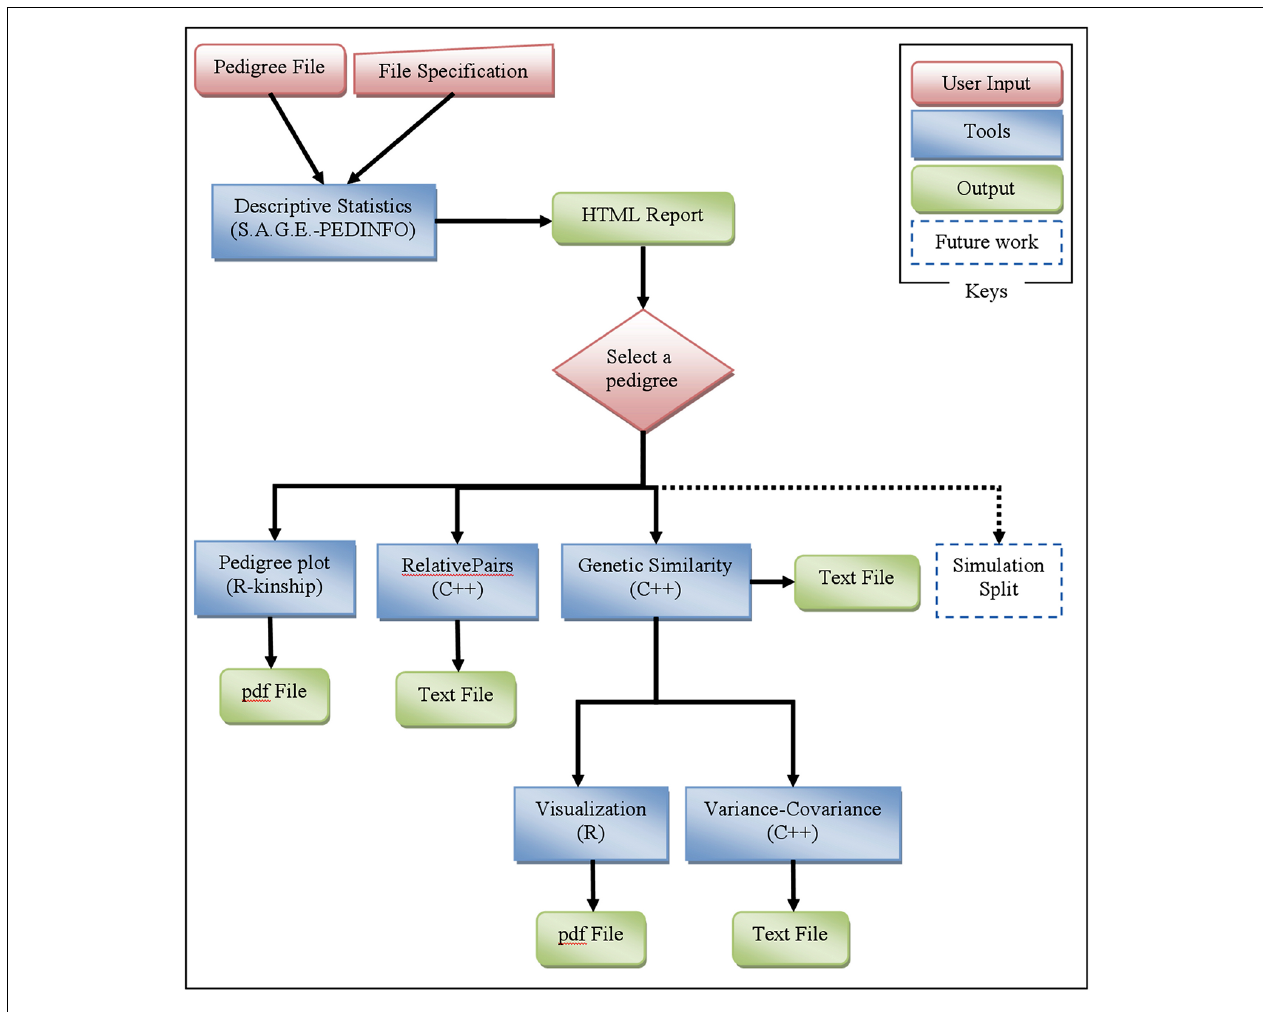
FIGURE 1 | PedWiz overview .This figure illustrates the analysis pipeline implemented in PedWiz. It consists of six tools to mine the information in a pedigree structure: descriptive statistics, pedigree plot, relative pairs, genetic